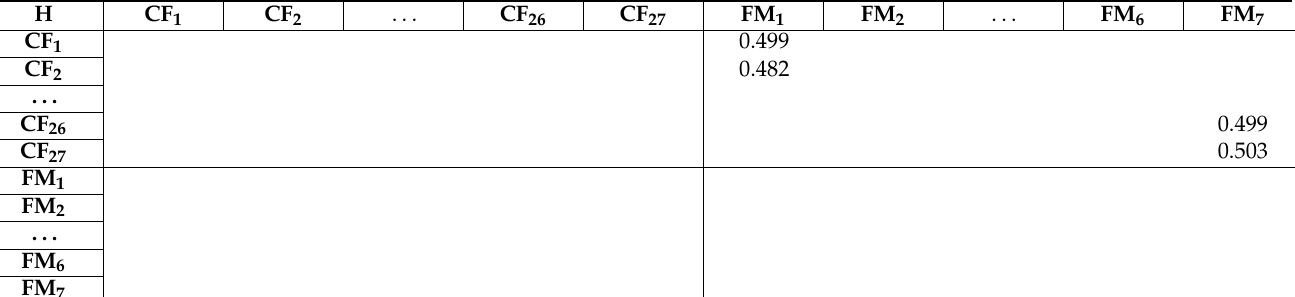
Table 12. The direct and indirect relation matrix T among FMs and CFs.